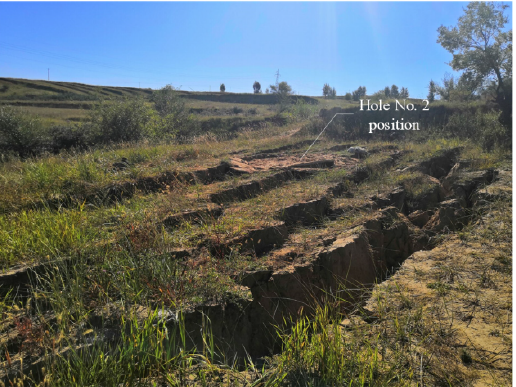
Figure 2. Surface fracture development near hole No. 2.